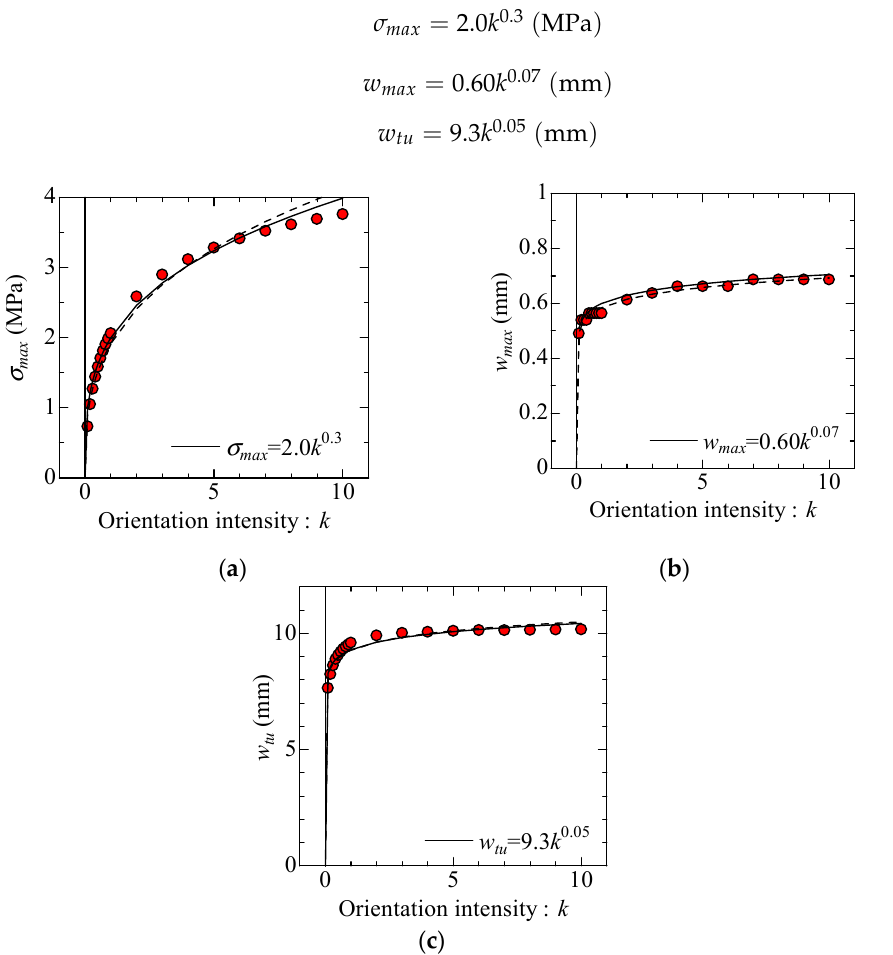
Figure 7. Relationship between each parameter of model and orientation intensity k : ( a ) σ max - k relationship, ( b ) w max - k relationship, and ( c ) w tu - k relationship.